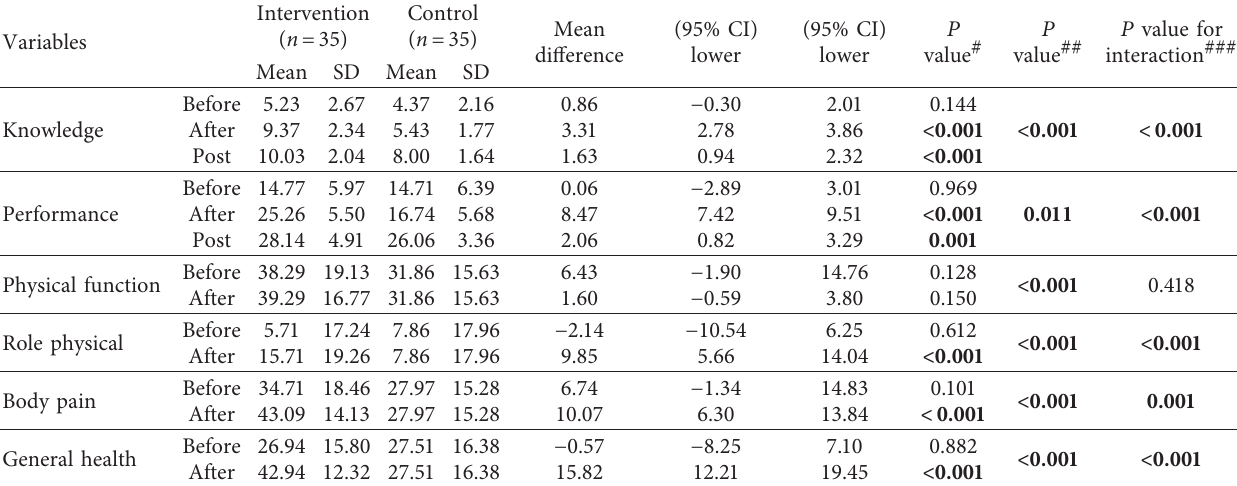
Table 2: Measurements of primary outcomes in intervention and control groups.